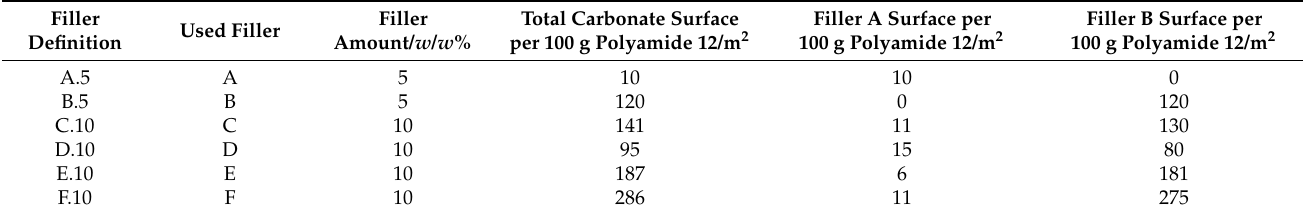
Table 4. Tested filler loadings and introduced surface area of filler per 100 g polyamide